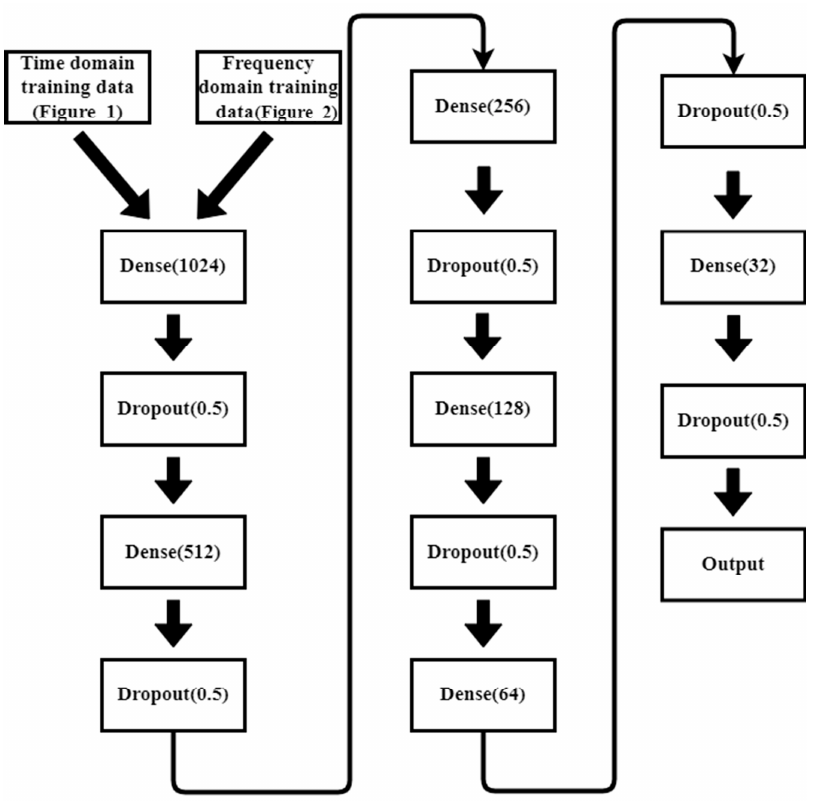
Figure 14. Multilayer perceptron (MLP) architecture used in this paper.